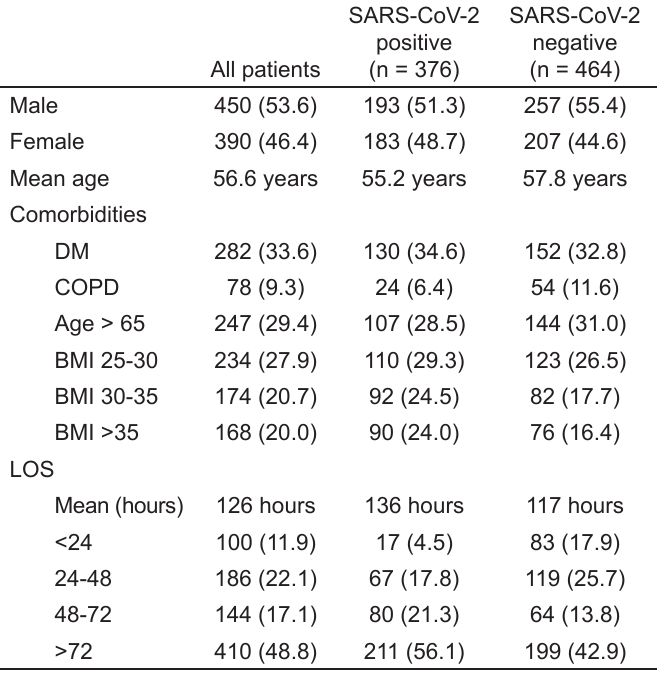
DM, diabetes mellitus; COPD, chronic obstructive pulmonary